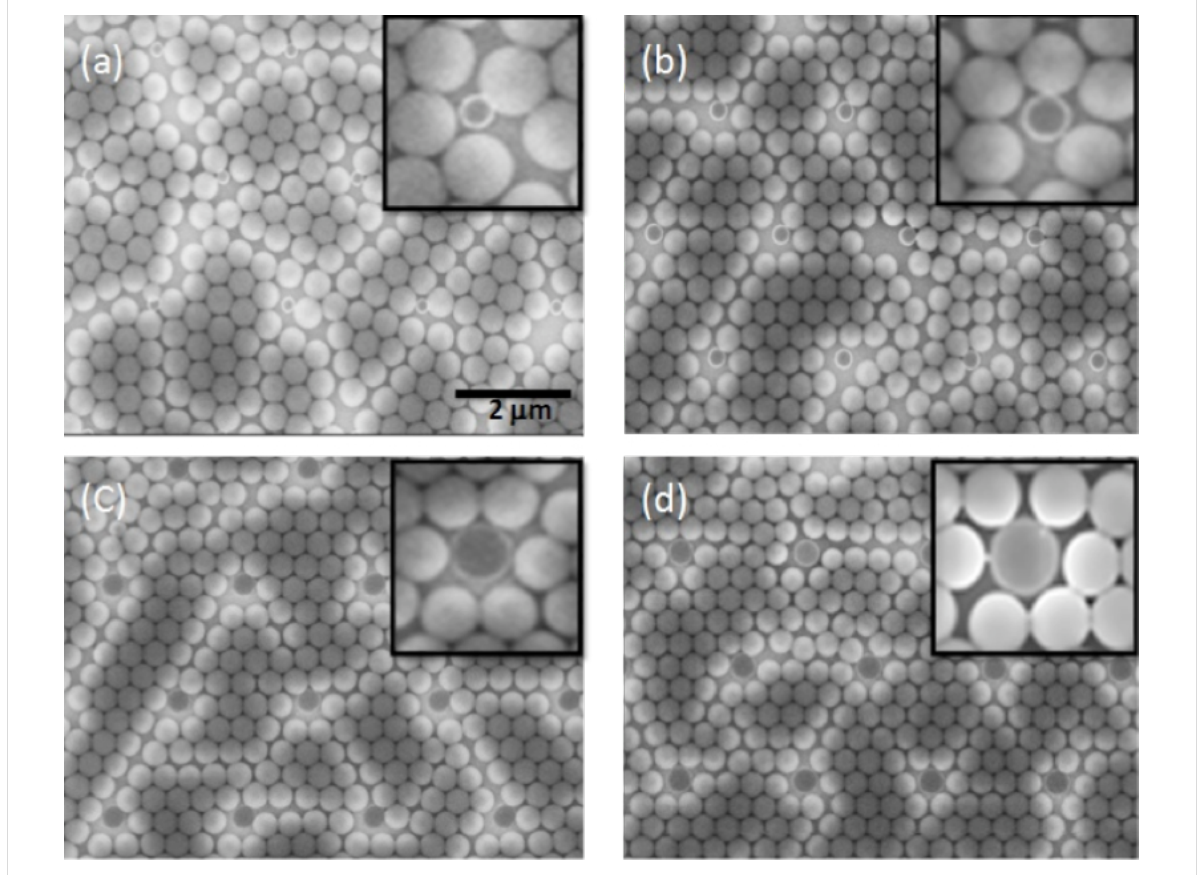
Figure 4: Influence of the pre-pattern post diameter: SEM images of self-assembled polystyrene beads on the post lattice template fabricated with a post diameter of (a) 195, (b) 296, (c) 390 and (d) 420 nm, respectively.